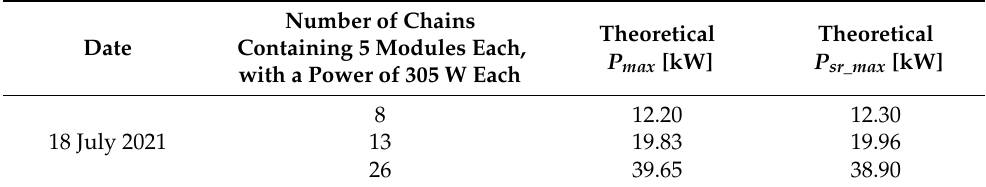
Table 1. Values of the power P sr _ max generated by photovoltaic installations obtained in simulations and